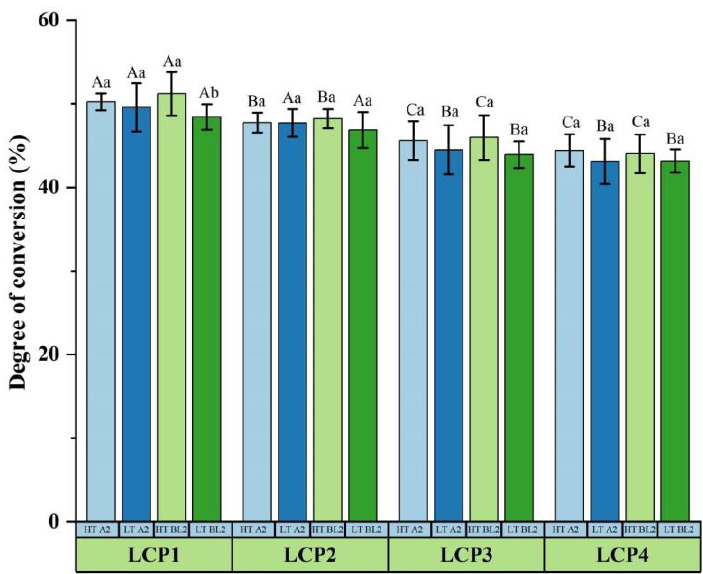
Figure 2. Degree of conversion observed for the different light-curing protocols and different ceramic optical properties. Different capital letters indicate statistically significant differences between groups for different light-curing protocols; different lowercase letters indicate statistically significant differences between different transparency groups of ceramic specimens; p < 0.05.